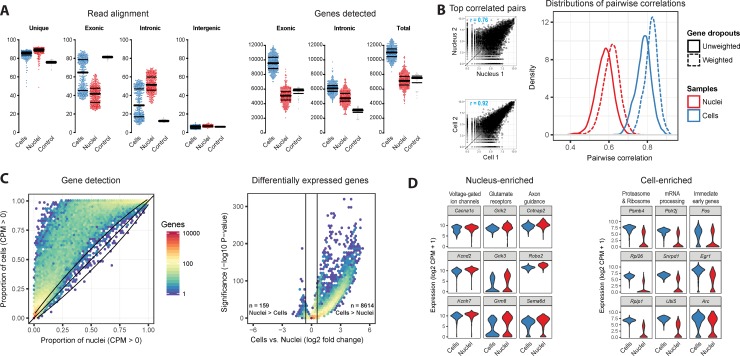
Comparison of nuclear and whole cell transcriptomes.(A) Left: Percentage of RNA-seq reads mapping to genomic regions for cells, nuclei, and whole-brain control RNA. Bars indicate median and 25th and 75th quantiles. Among cells, exonic and intronic read percentages display bimodal distributions. Right: Gene detection (counts per million, CPM > 0) based on read mapping to exons, introns, or both introns and exons. (B) Left: The most similar pair of cells have more highly correlated gene expression (r = 0.92) than the most similar pair of nuclei (r = 0.76), due to fewer gene dropouts in cells. Right: Cells have consistently more similar expression to each other than nuclei, even after correcting for gene dropouts based on expression noise models. (C) Left: Binned scatter plot showing all genes are detected (CPM > 0) with equal or greater reliability in cells than in nuclei. Black lines show the variation in detection that is expected by chance (95% confidence interval). Right: Binned scatter plot showing 0.4% of genes are significantly more highly expressed in nuclei, and 20.5% of genes are more highly expressed in cells (for both comparisons, fold change > 1.5, adjusted P-value < 0.05). The log-transformed color scale indicates the number of genes in each bin. (D) Examples of nucleus-enriched transcripts involved in neuronal connectivity, synaptic transmission, and intrinsic firing properties and cell-enriched transcripts related to mRNA processing and protein translation and degradation. In addition, expression of immediate early genes is up to 10-fold higher in cells.